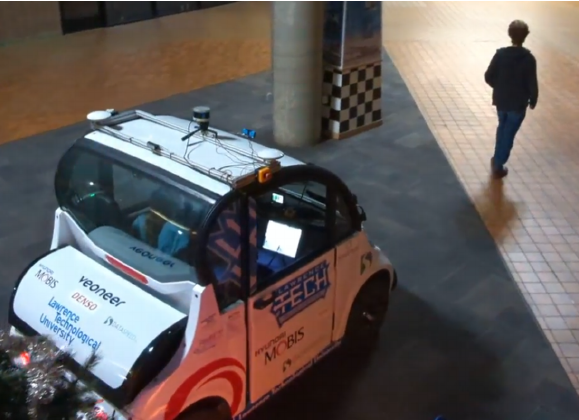
Figure 13. ACTor 1 autonomously follows author M. Kocherovsky in the atrium of Lawrence Technological University. Author J. Schulte sits in the driver’s seat as a safety precaution. Picture taken by author M.